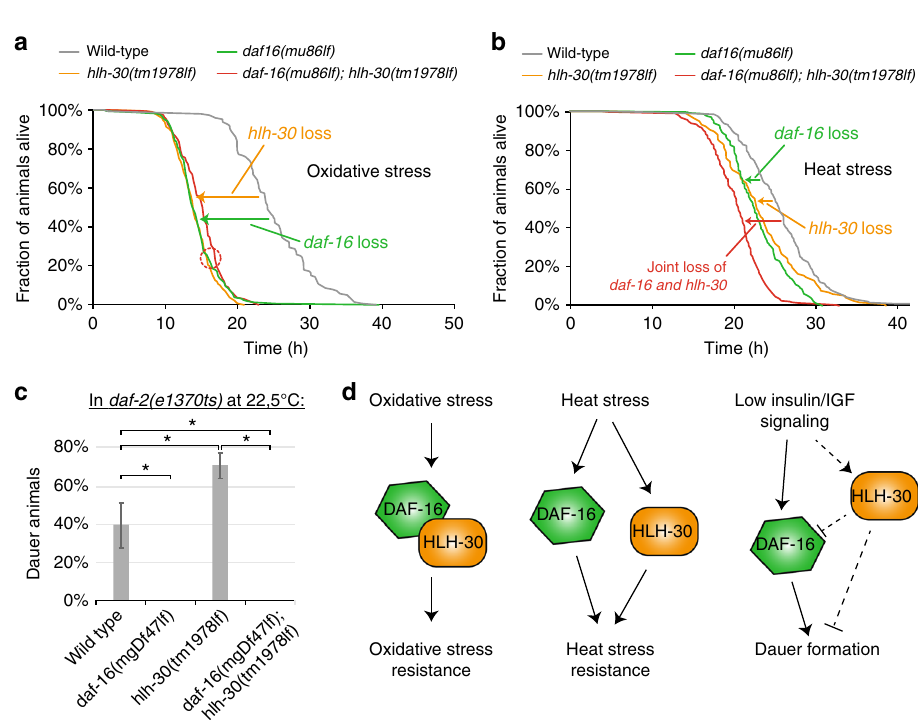
Fig. 6 The genetic interaction between daf-16 and hlh-30 is context-dependent. a , b Stress survival phenotypes caused by loss of daf-16 and/or hlh-30 . Animals of indicated genotpyes were grown at 20 °C until day 1 adulthood, then transferred to either 6 mM tBOOH (oxidative stress) ( a ) or to 32 °C (heat stress) ( b ). ( n ≥ 116, for detailed statistics including log-rank tests see Supplementary Table 2.) c Dauer formation phenotypes caused by loss of daf-16 and/or hlh-30 in daf-2(e1370ts) animals. Eggs of indicated genotypes were hedged and grown at 22.5 °C for 3 days. Dauer formation was scored based on developmental arrest and morphology. ( n = 100, results from biological triplicates, *: p < 0.05, t -test, error bars indicate s.d.) d Models illustrating the genetic interactions between daf-16 and hlh-30 for the promotion of oxidative stress resistance, heat stress resistance, and dauer